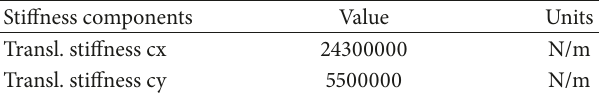
Table 3: Stiffness of the axle-box guide.